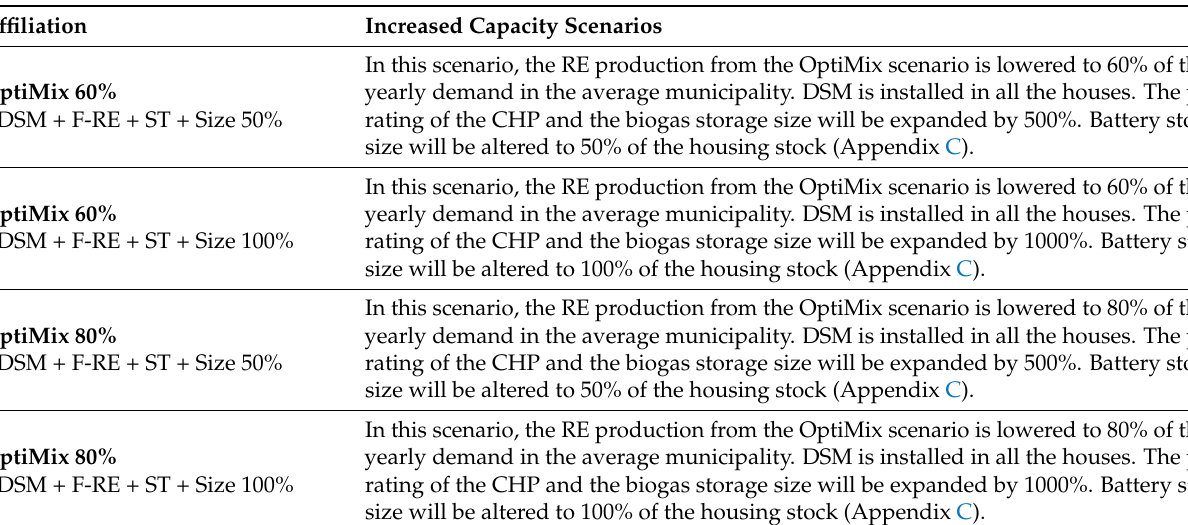
Table A20. Lowering the RE production scenarios.